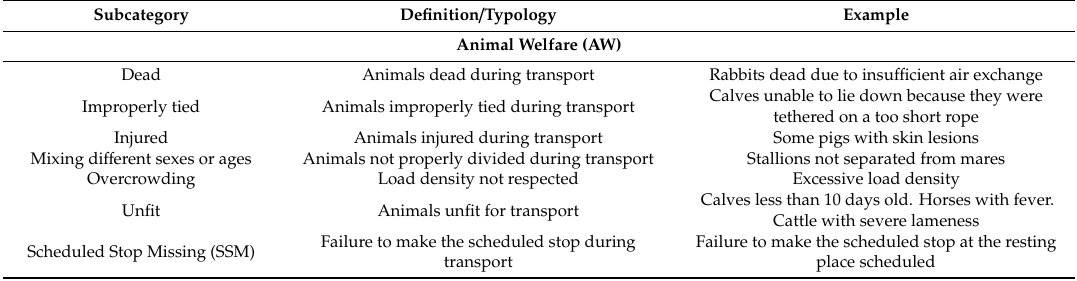
Table 1. Categories and subcategories of the infringements. Commercial vehicles that were transporting animals were sanctioned for failure to comply with one of more articles of Council Regulation (EC) 1 / 2005. The infringements that were recorded during the inspections were divided into three main categories: animal welfare (AW), vehicle (V), and accompanying documents